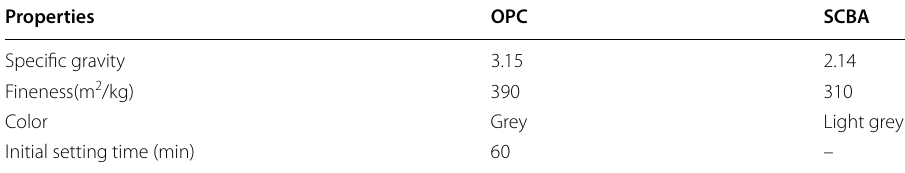
Table 2 Physical properties of SCBA and OPC